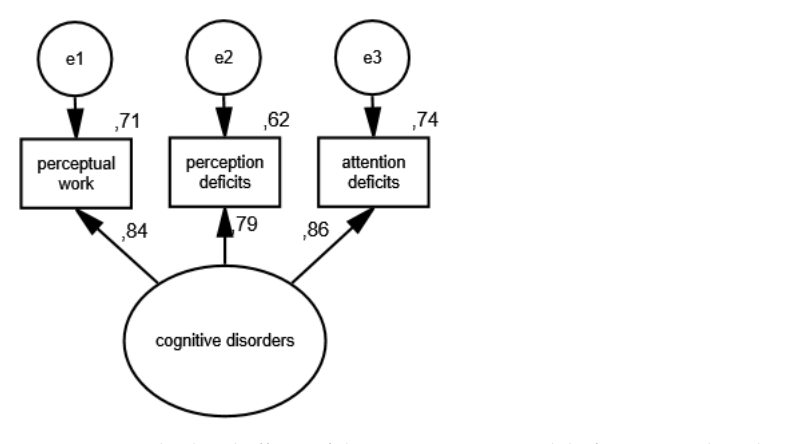
Figure 6. Standardized effects of the measurement model of cognitive disorders in the group of men .